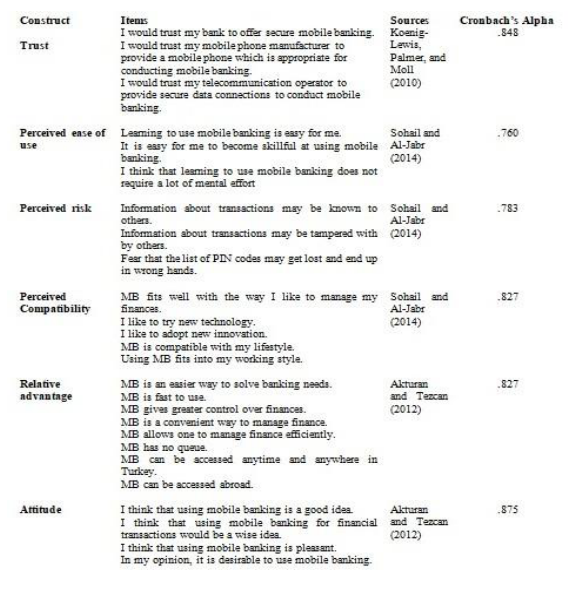
Table 2: Questionnaire